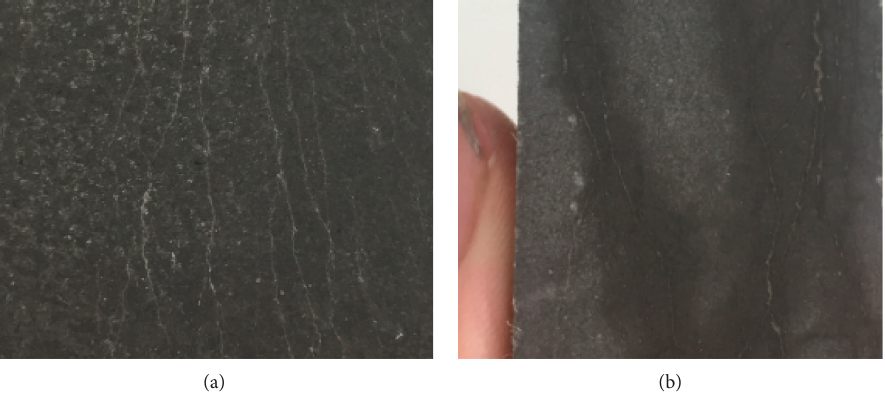
Figure 11: Macroimages of self-healing.